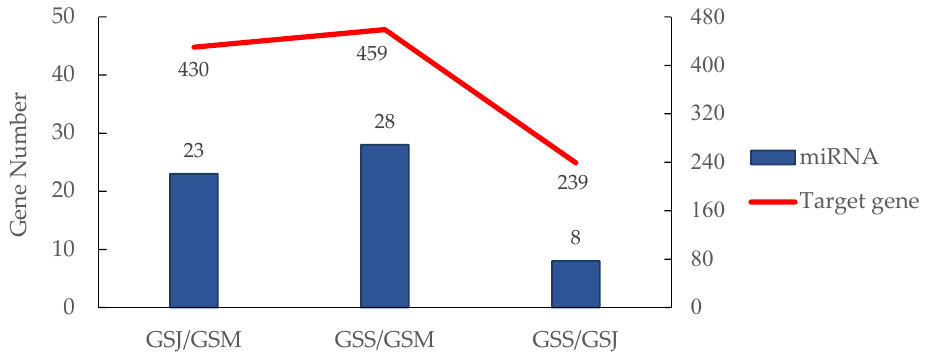
Figure 5. The number of differentially expressed miRNAs with targets in three comparison groups of